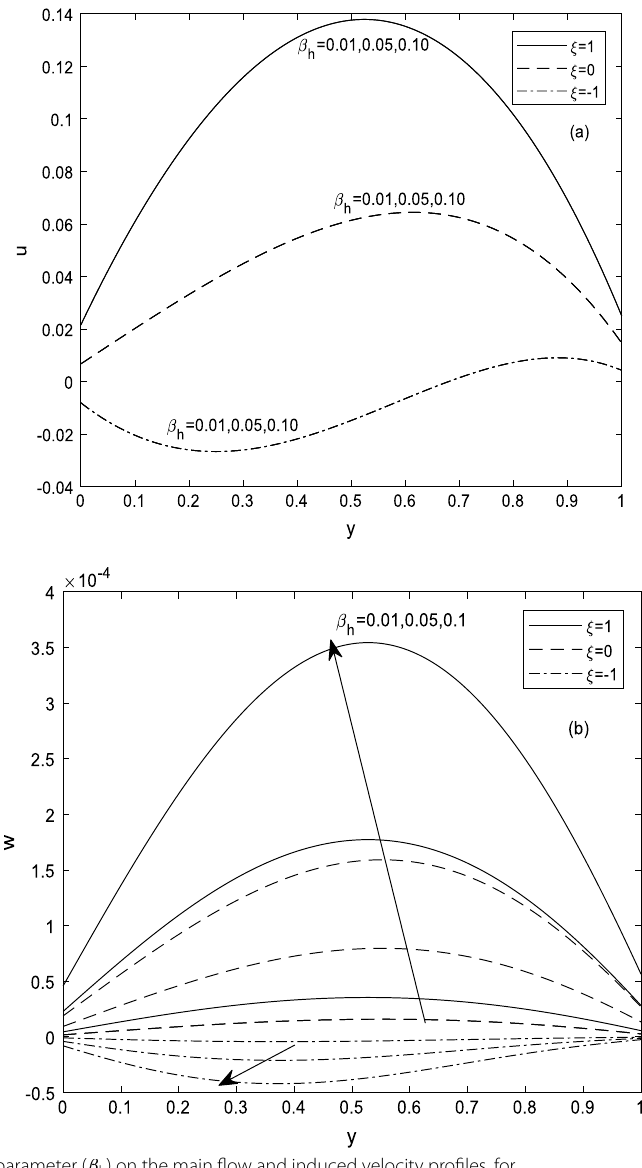
v Kn = 0.05, M = 2,ln = 1.667, S = 0.5, β i = 3.0 and Pr = 0.71 . b Hall parameter ( β h ) on the main flow